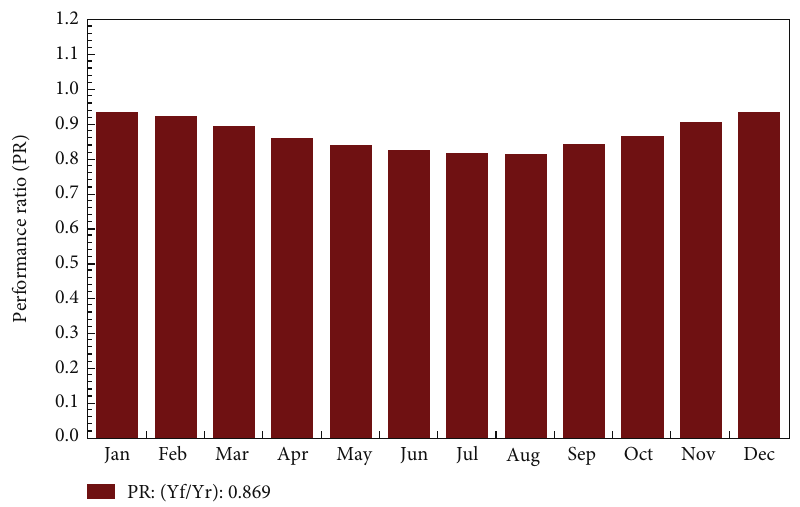
Figure 6: Self-generated electricity for self-use and surplus electricity for grid-connection system.